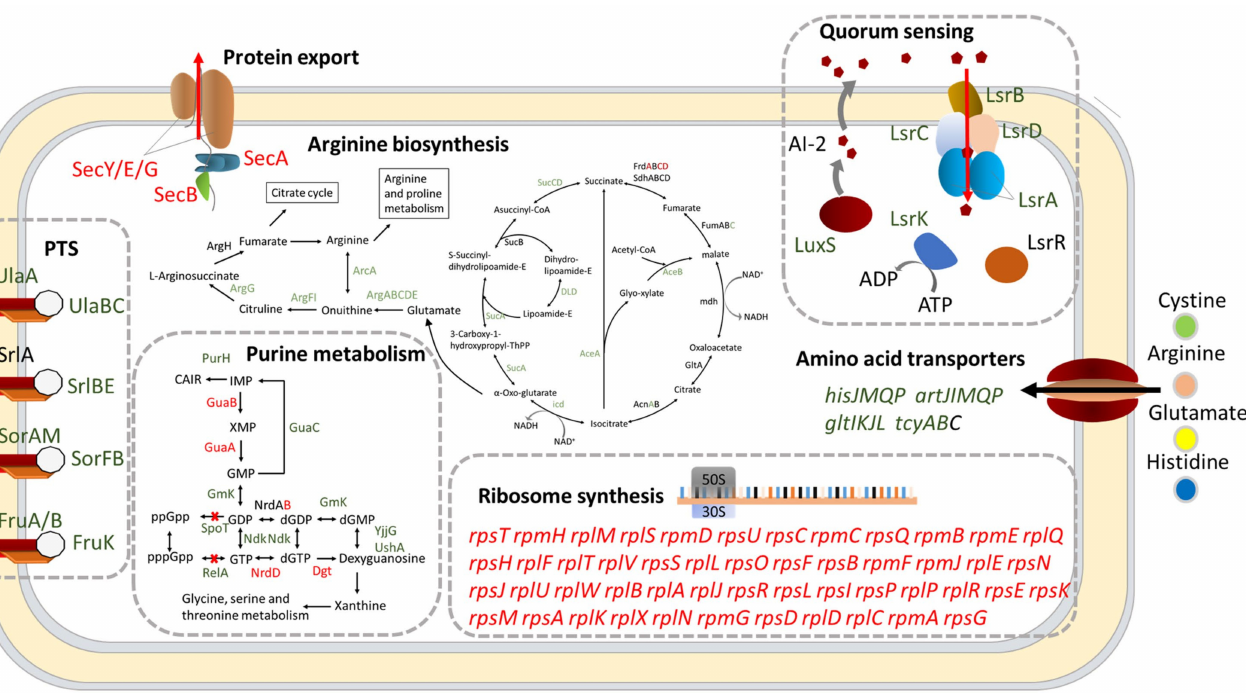
Figure 5. The model for the cellular processes of ∆ relA ∆ spoT . Red, green, and black indicate significant upregulation (FC > 2 and p -adjust < 0.05), significant downregulation (FC < 0.5 and p -adjust < 0.05), and no significant regulation (0.5 ≤ FC ≤ 2 or p -adjust ≥ 0.05),